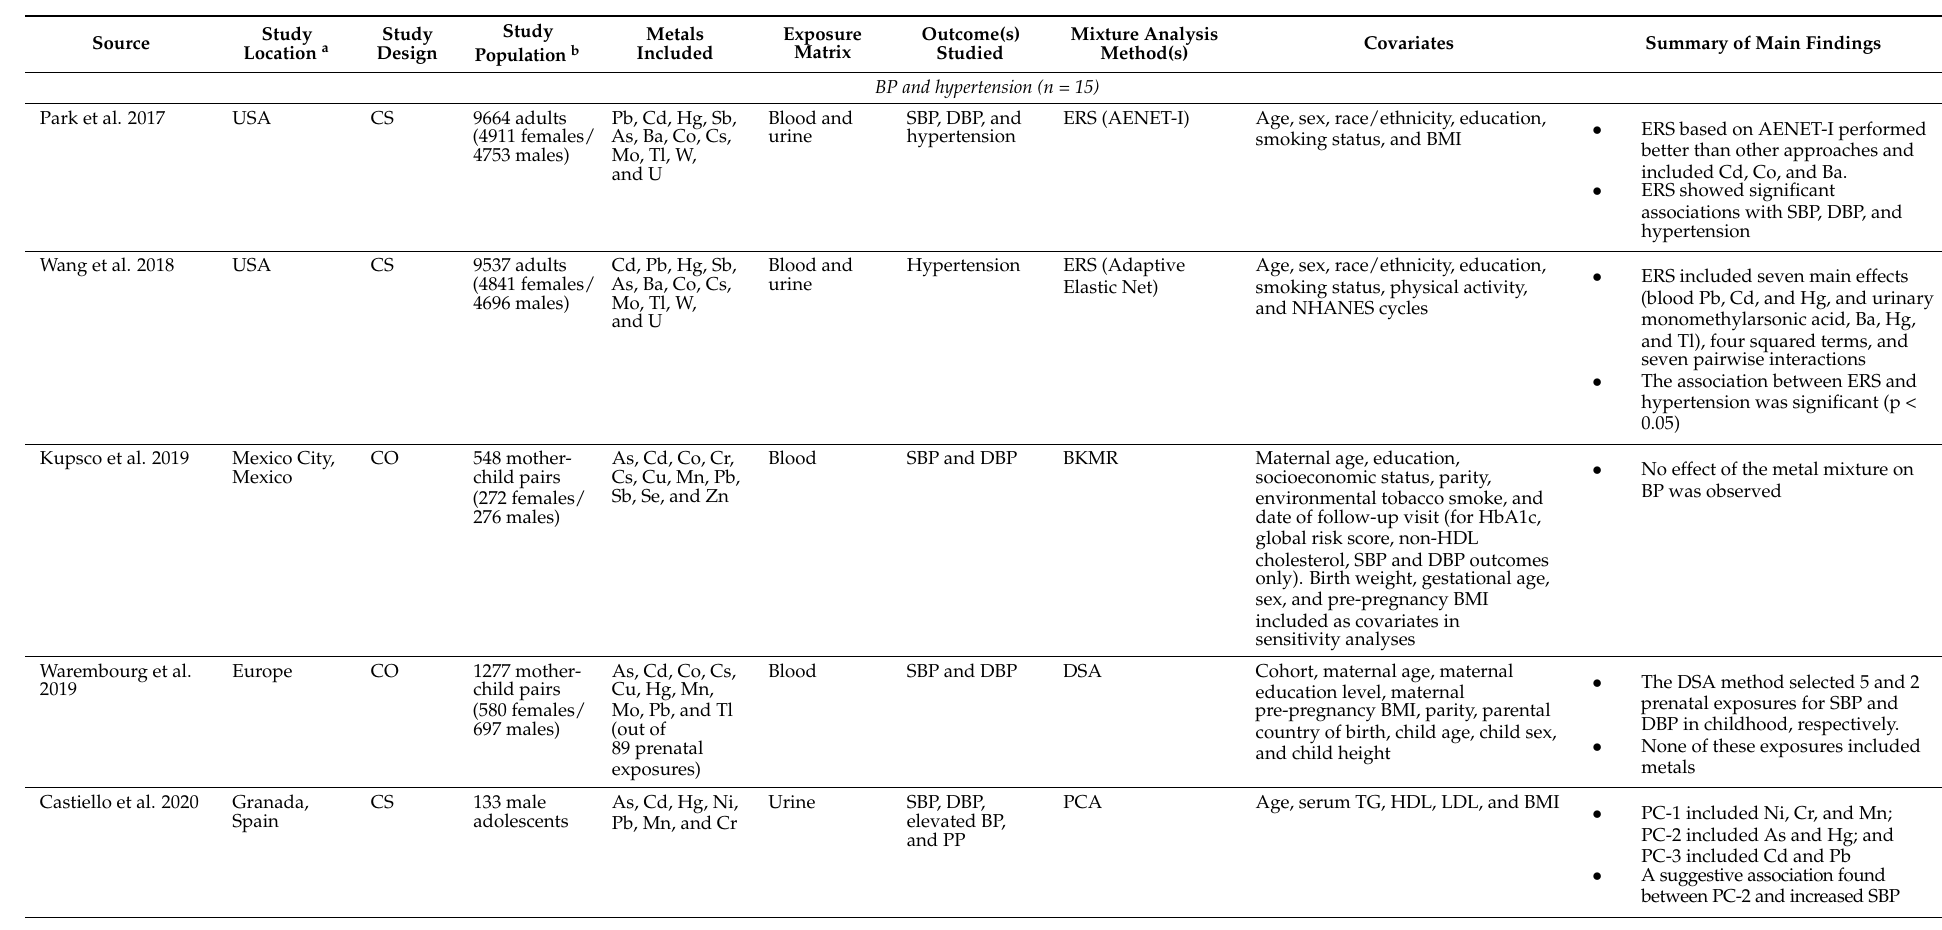
Table 2. Studies included in the